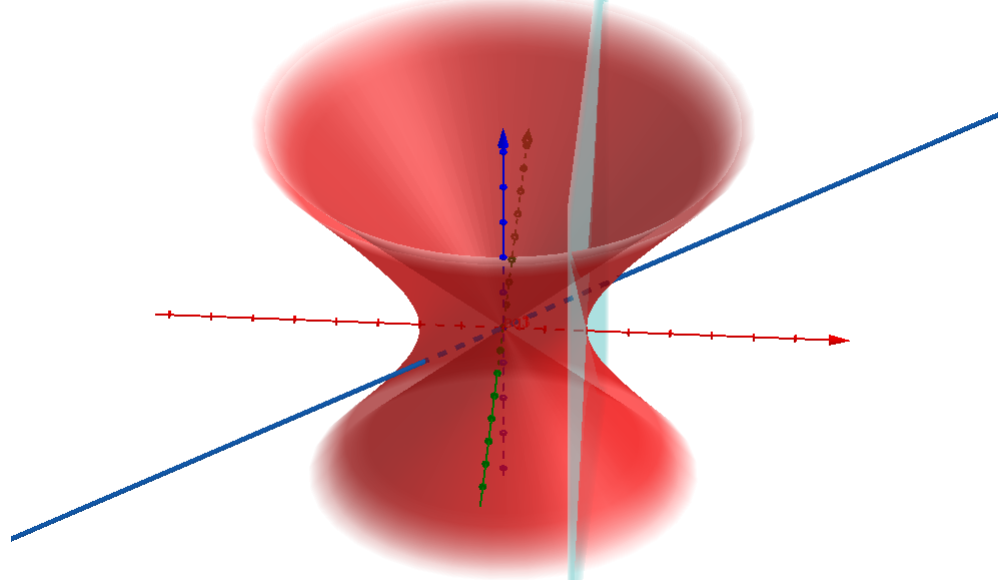
Figure 1. In a low-dimensional version, the following geometric elements in the five-dimensional Euclidean space are represented: (a) the coordinate axes ( x in red, y in green, t in blue); (b) the five-dimensional light-cone with vertex in the origin x = y = t = 0; (c) the hyperboloid whose surface is the de Sitter space (in red); (d) the Minkowski space ( y , t ) tangent to the hyperboloid (sky blue); (e) a line of gnomonic projection from the origin to the tangent space (blue, dashed) and its extension (blue, solid